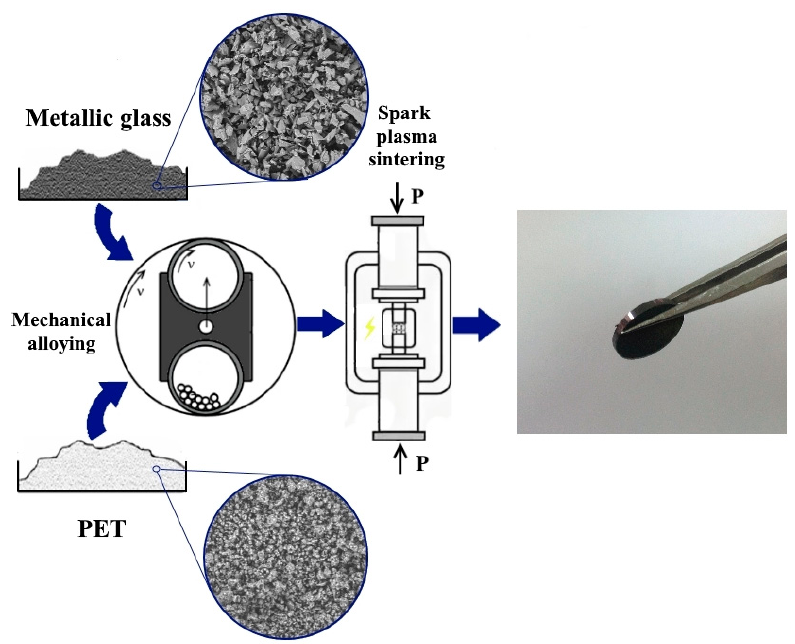
Figure 1. Scheme used for manufacturing samples using a ball milling technique and subsequent spark plasma sintering.